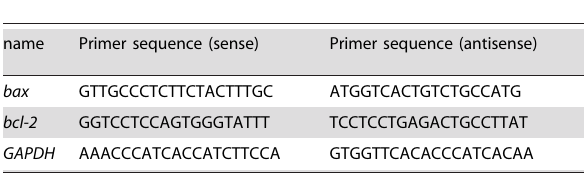
Table 1. The primer sequences for RT-PCR.